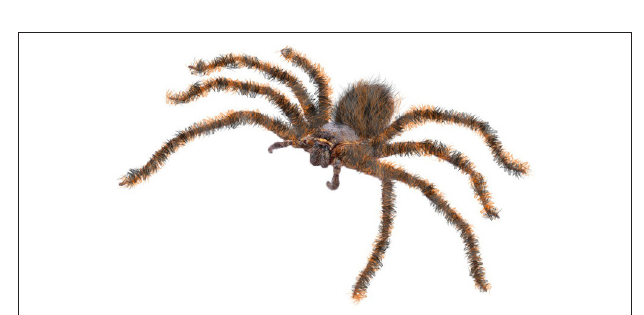
FIGURE 5 | Experimentally manipulated abdomen of spider.